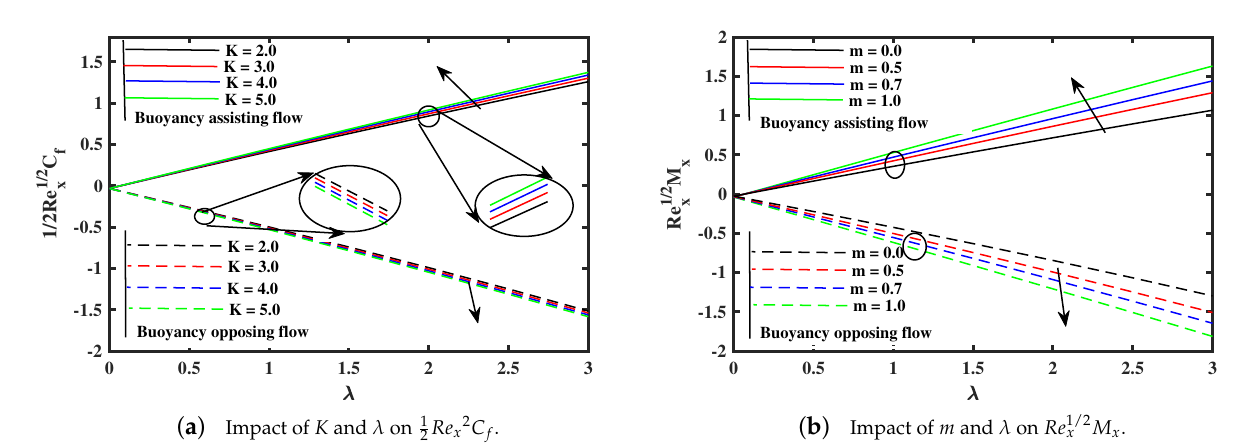
Re x 2 C f and Re 1/2 x M x against material parameter ( K ), microrotation concentration ( m ), and Figure 14. Fluctuation of 1 2 thermal buoyancy ( λ